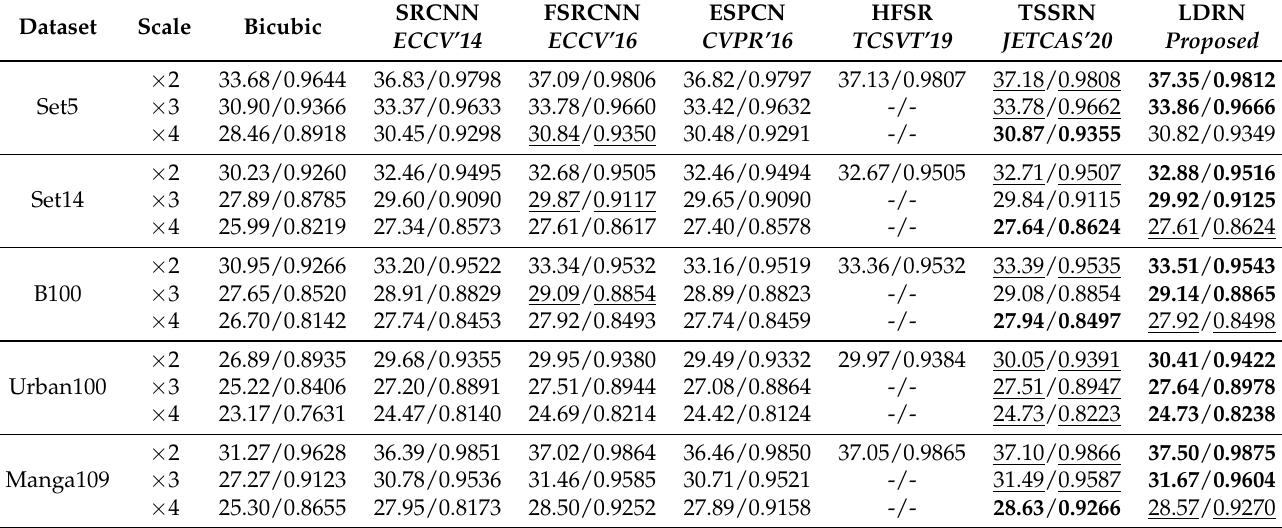
Table 3. The results of PSNR and SSIM on public benchmark datasets (Bicubic). Bold indicates the best performance, while Underline indicates the second